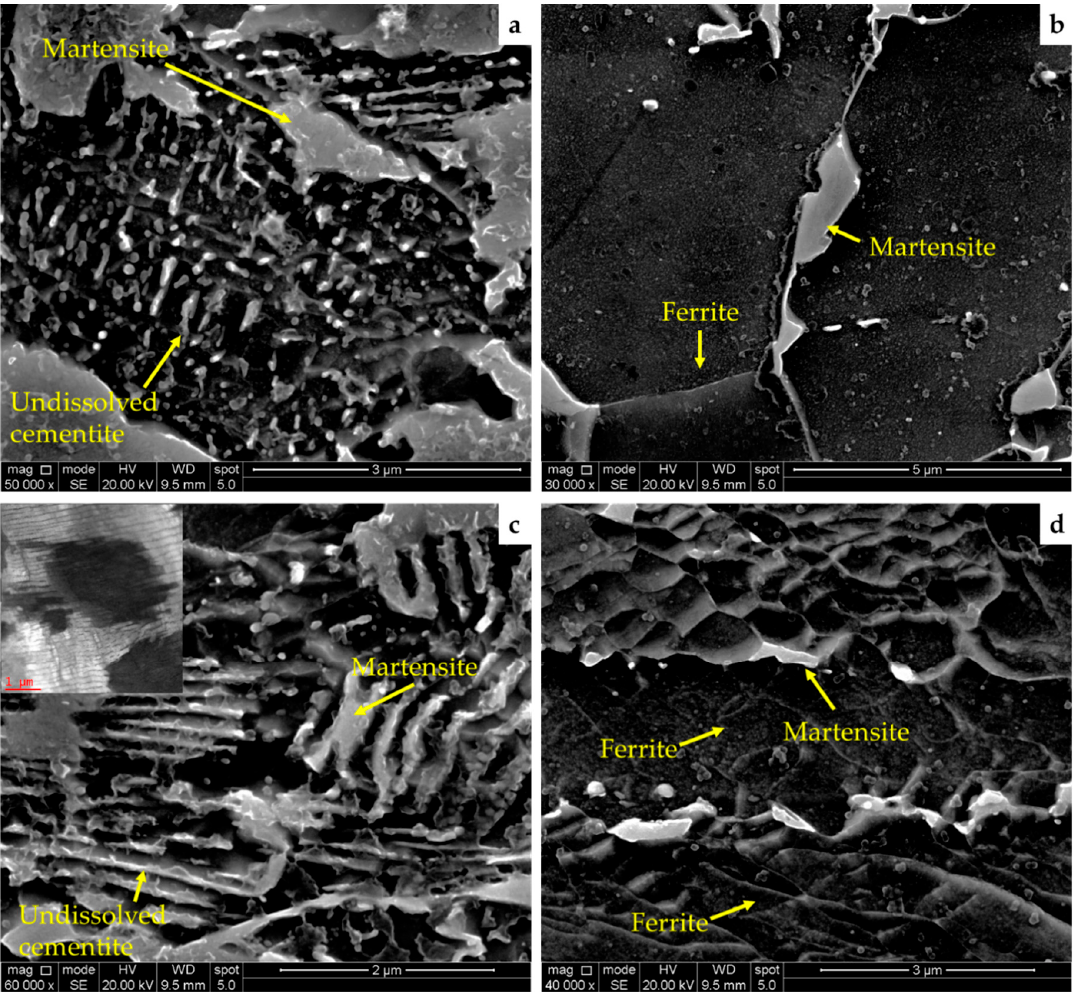
Figure 4 . ( a , b ) SEM micrographs of the CH sample showing the nucleation of the prior austenite (transformed into martensite during quenching) taking place on both α / α and α / θ interfaces. The same can be seen in the UFH sample in ( c , d